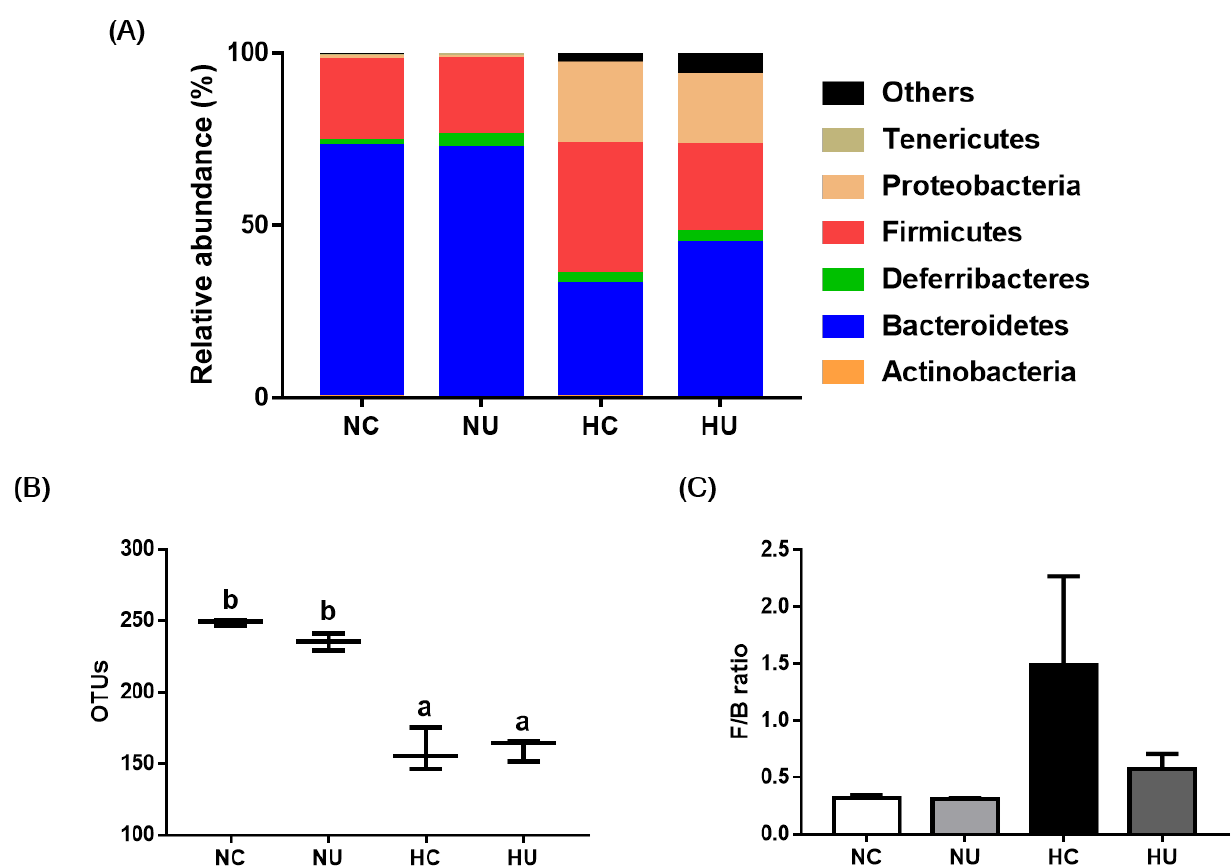
Figure 6. Effects of Bacteroides uniformis CBA7346 treatment on gut microbiota composition obtained through 16S rRNA pyrosequencing of microbiota from feces of mice with high-fat diet-induced non-alcoholic fatty liver disease. ( A ) relative abundance plot of bacteria at the phylum level; ( B ) plots of operational taxonomic units; ( C ) ratio of Firmicutes to Bacteroidetes. NC, control group on normal diet; NU, group on normal diet receiving 1 × 10 6 CFU B. uniformis CBA7346 thrice a week; HC, control group on high-fat diet; HU, group on high-fat diet receiving 1 × 10 6 CFU B. uniformis CBA7346 thrice a week. Data are presented as mean ± SEM ( n = 3). Means with different letters (a,b) are significantly different ( p < 0.05). Groups were compared using Duncan’s multiple range tests.